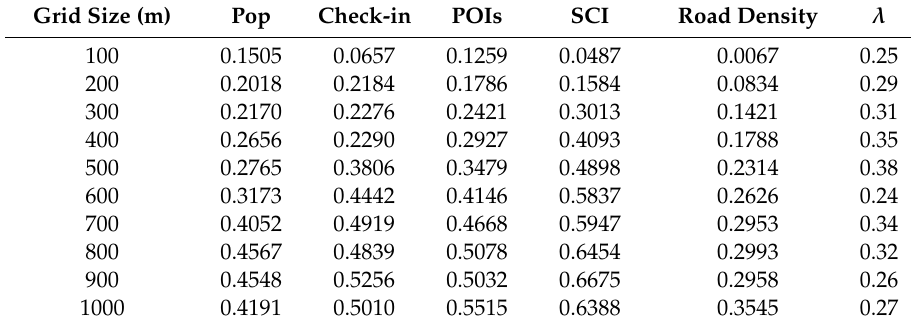
Table 4. Pearson correlation coe ffi cient (PCC) of features and sales within di ff erent grid sizes. Grid Size